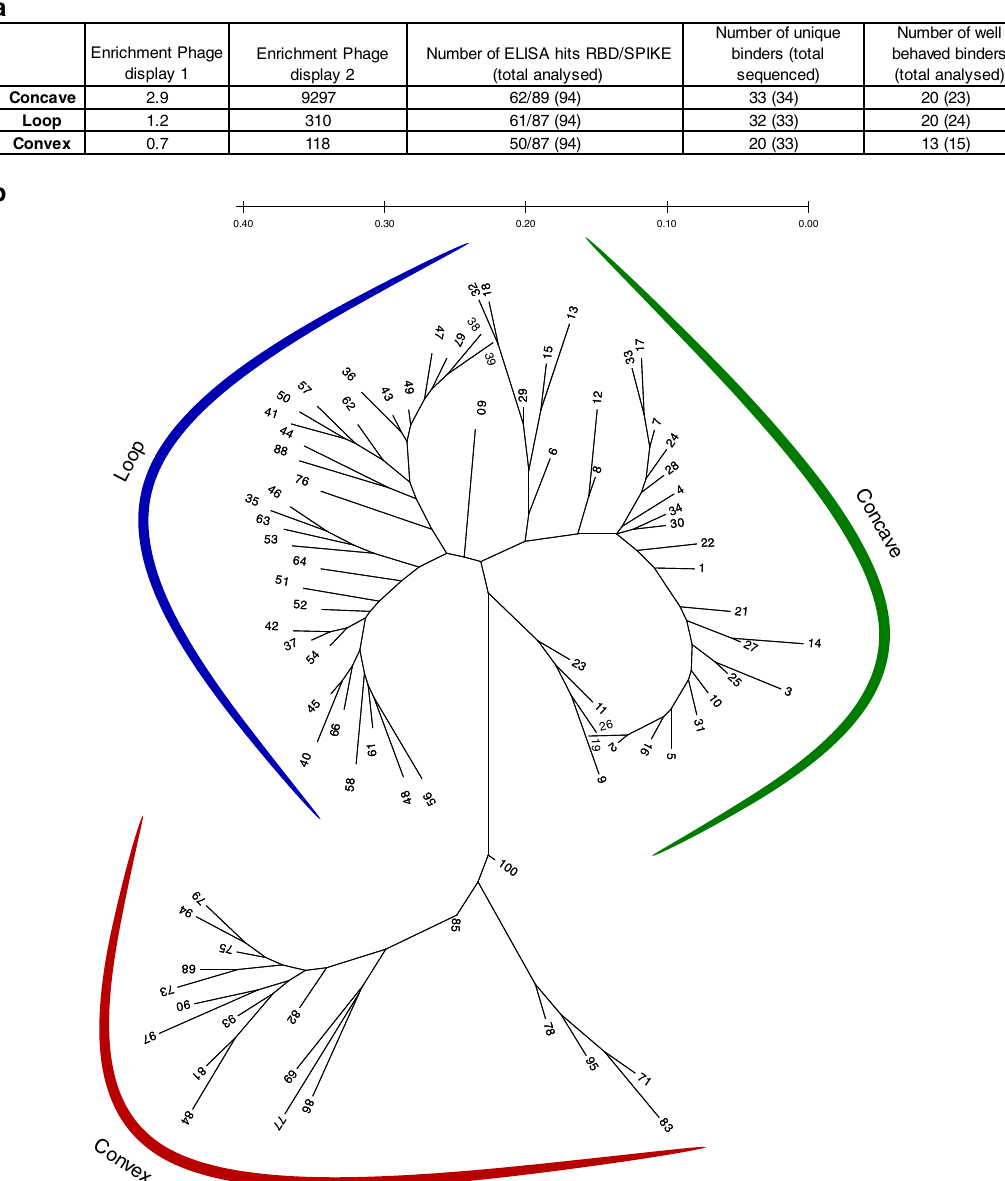
Fig. 1 Selection of sybodies against SARS-CoV-2 RBD. a Sybody selection statistics for the three different libraries. b Radial phylogenetic tree of all unique binders identi fi ed in this study. Sequence alignment was performed using PROMAL3D and the phylogenetic tree was construct using the maximum likelihood (ML) analysis in MEGA. Two sybodies (76 and 88), expected to stem from the convex library, were found to belong to the loop library, presumably due to a spill-over during the selection procedure.